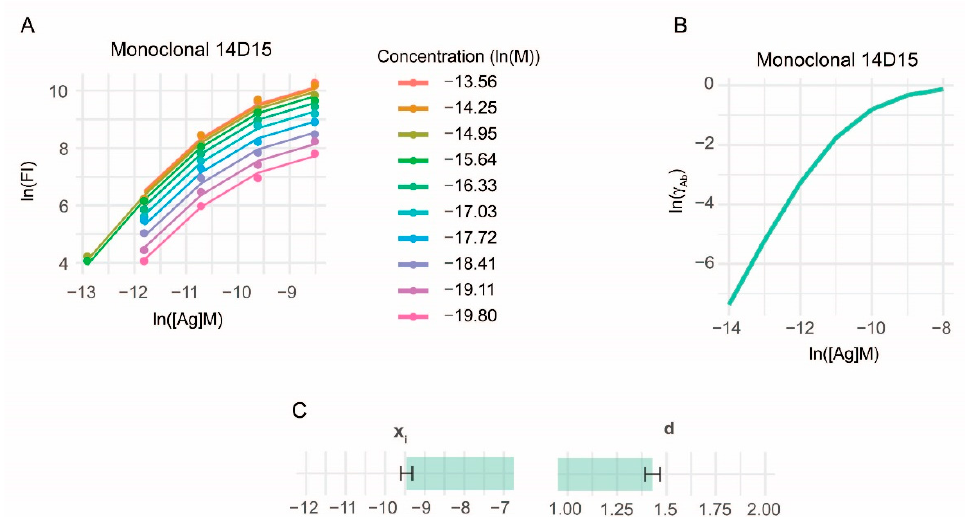
Figure 5. Characterization of a monoclonal Ab for reference. Binding data of monoclonal Ab 14D15 was fitted using the same algorithm as for serum antibodies. Binding data and fitted curves ( A ), calculated distribution of activity coefficient ( B ) and estimates of parameters x i and d ( C ) are shown.